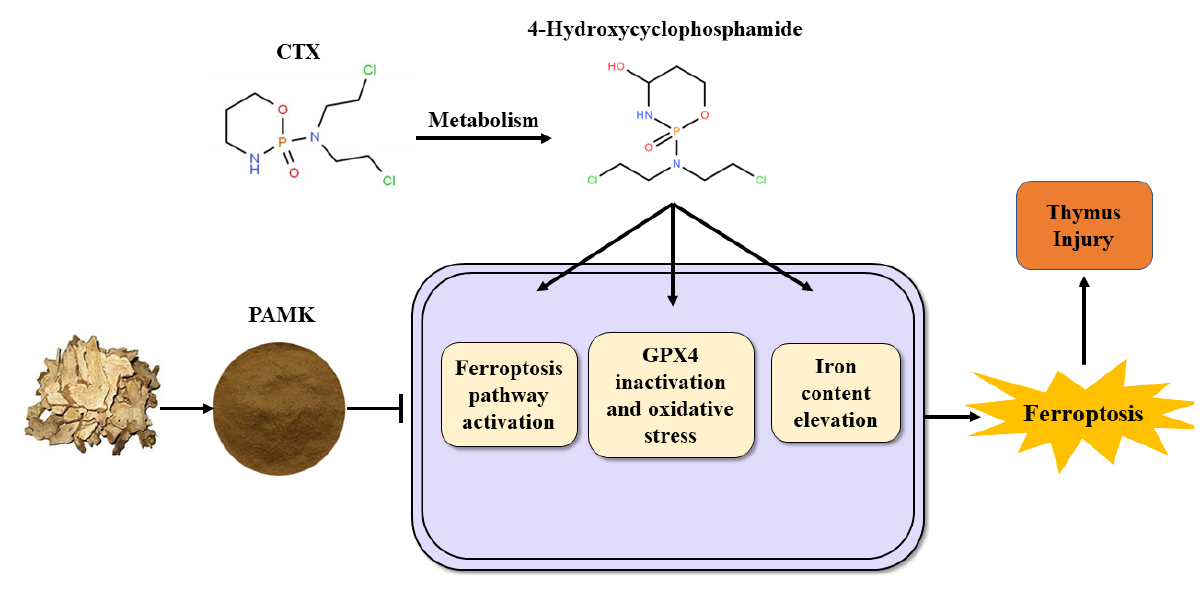
Figure 7. Propose mechanism of PAMK alleviation of CTX-induced thymocyte Ferroptosis in gos-